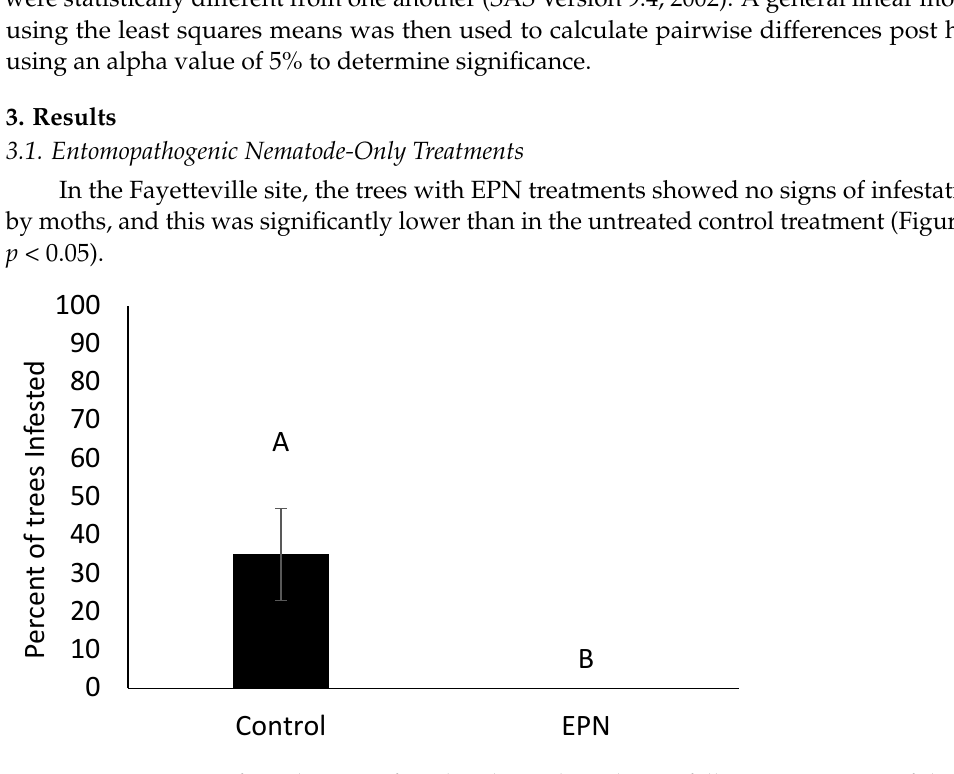
Figure 1. Percentage of peach trees infested with peachtree borers following treatment of the en- tomopathogenic nematode (EPN), Steinernema carpocapsae . Control = no nematodes applied. The application was made in an organic peach orchard in fall 2018 with a reapplication and assessment in spring 2019. Different letters above bars indicate significant differences ( p <